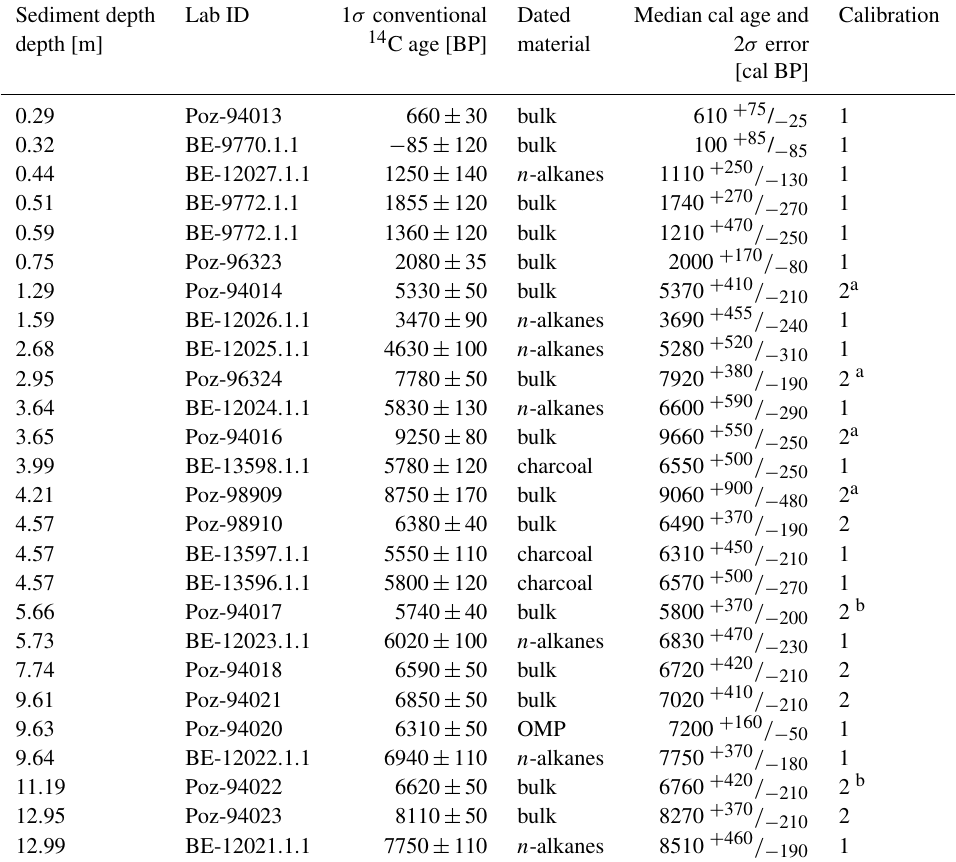
Table 2. Conventional radiocarbon ages as well as 2 σ calibrated age ranges and median calibrated ages (Calib 8.2) (Stuiver et al., 2020) using the SHCal20 and Marine20 calibration curve (Heaton et al., 2020; Hogg et al., 2020) of dated bulk sediment, n -alkanes and organic macro particle (OMP) samples from the VOV16 record. Samples from the marine and brackish parts of the record were reservoir corrected using a (cid:49) R of 134 ± 38 14 C years after Wündsch et al. (2016b). 1: SHCal20; 2: Marine20 and reservoir corrected using a (cid:49) R of 134 ± 38 14 C years after Wündsch et al. (2016b).